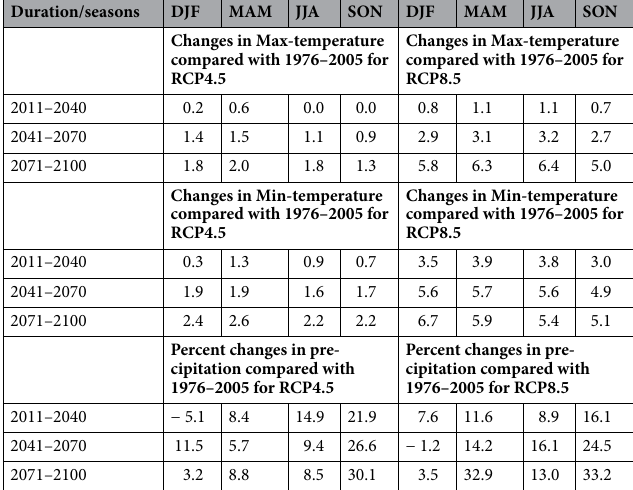
Table 2. Changes in maximum, minimum temperature and precipitation with respect to the baseline period (1976–2005) for different seasons under the RCP4.5 and RCP8.5. The unit of change in temperature is 0 C while for precipitation percent changes are presented. The changes are in comparison to the baseline duration